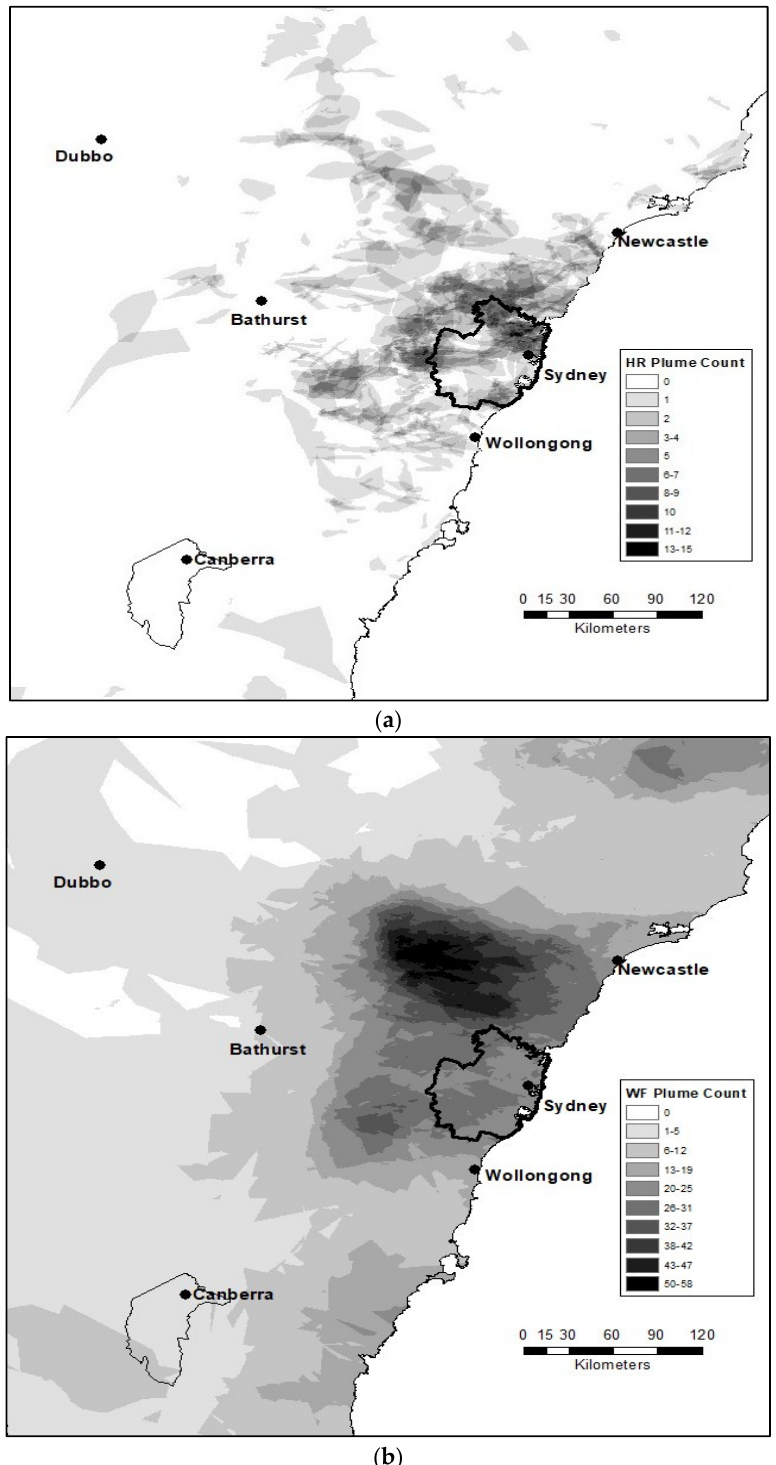
Figure 1. Map of smoke plume frequency for 2002–2020 for ( a ) prescribed burns and ( b ) wildfires. The Greater Sydney area is outlined in black. High density in b is centered on Wollemi National Park. Notice the different scales for the